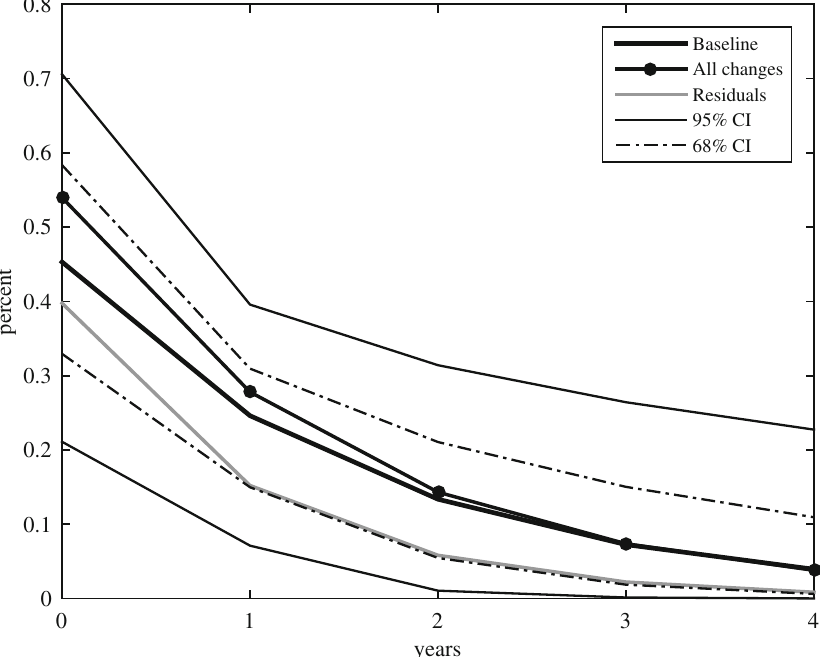
Fig. 2 Dynamic response of output to transfers shocks. Notes: response to an increase in old age pensions equivalent to 1% of GDP. Transfer shocks are the narrative variable including only exogenous changes (black), all changes (marker), or residualised (grey). Full lines are point estimates; thin and broken lines indicate one and two standard deviations confidence intervals,